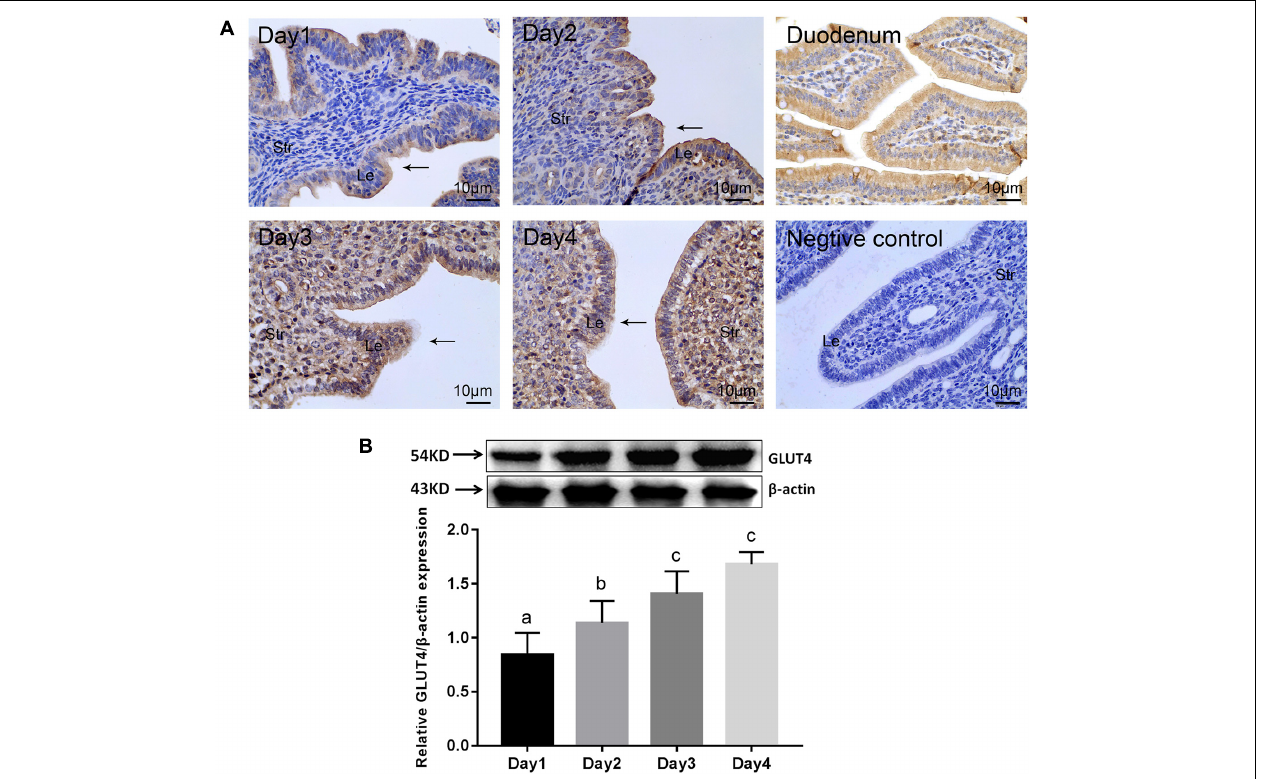
FIGURE 1 | | GLUT4 expression in the mouse endometrium on pregnant days 1–4. Mouse uterine tissues were collected on days 1–4 of pregnancy. One side of the uterine horns was fixed in 4% paraformaldehyde for paraffin blocks and the other side was stored at − 80 ◦ C for Western blotting analysis, n = 10 per group. (A) Immunohistochemistry (IHC) staining for GLUT4 expression in the mouse endometrium. Le , luminal epithelium; Str , stromal tissue. Arrows indicate the luminal epithelium. GLUT4 expression in the mouse duodenum for the positive control, without the primary antibody for the negative control. Scale bar , 10 µ m. (B) Western blotting analysis for GLUT4 expression in the mouse endometrium on pregnant days 1–4. Relative density analysis of GLUT4 by Image Lab 3.0 software ( n = 3) normalized by β -actin. Different superscript letters ( a , b , c ) denote significant differences among groups ( P < 0.05); the same superscript letters mean no significant difference ( P >